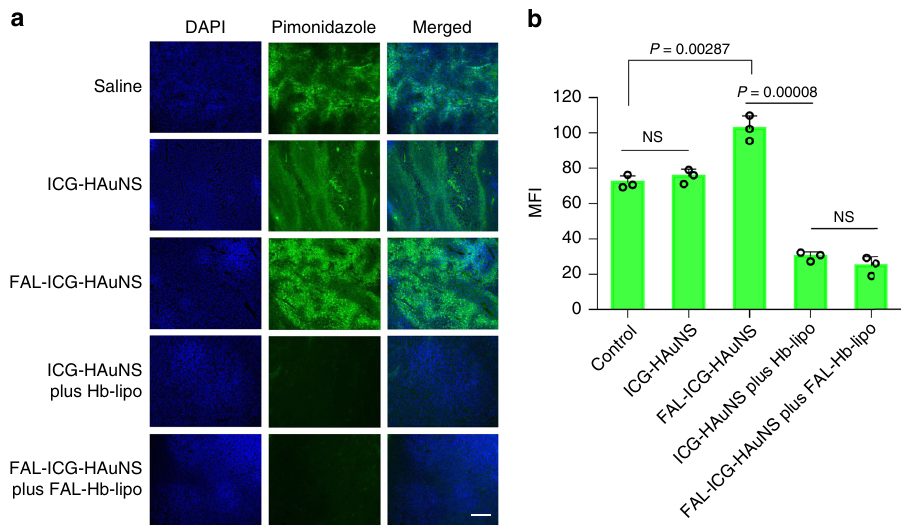
Fig. 7 Relief of tumor hypoxia microenvironment in CT-26 model. Laser power: 1 W/cm 2 , 2 min. a Representative hypoxia fl uorescent photomicrographs of tumors in each group. Scale bars, 200 μ m. b Mean fl uorescence intensity in the tumor slices ( n = 3). All data were analyzed with one-way analysis of variance test. All error bars are expressed as ±SD. “ NS ” indicates “ not signi fi cant ”